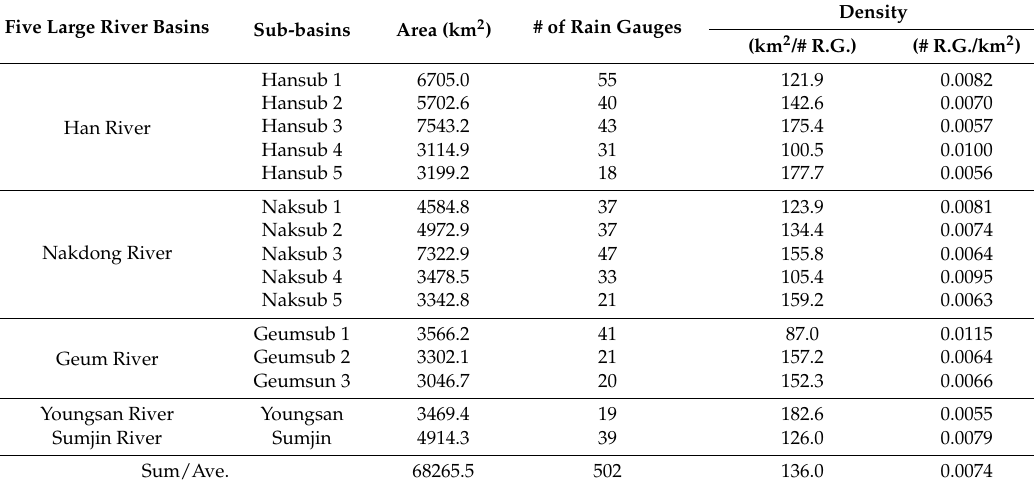
Table 2. Sub-basin Characteristics and the Density of Rain Gauges.